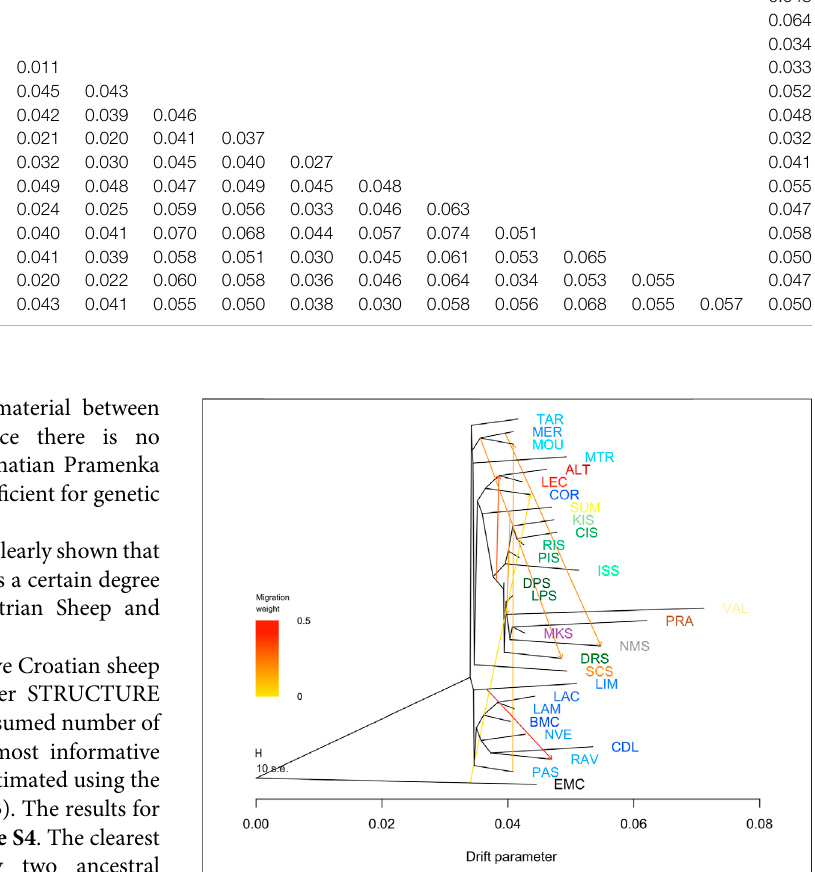
TABLE 2 | Genetic differentiation (F ST) between native Croatian sheep breeds and selected European breeds. MF ST — average F ST estimates among breeds. Breed DPS-Dalmatian Pramenka